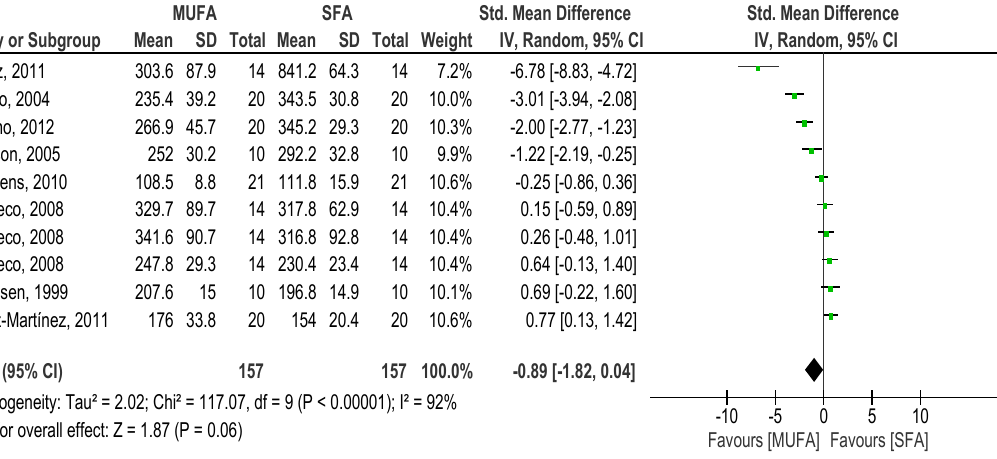
Figure 4. Forest plot of postprandial triglycerides of saturated fatty acids compared to monounsaturated fatty acids over 8 hours. Nutrients 2016 , 8 , 580